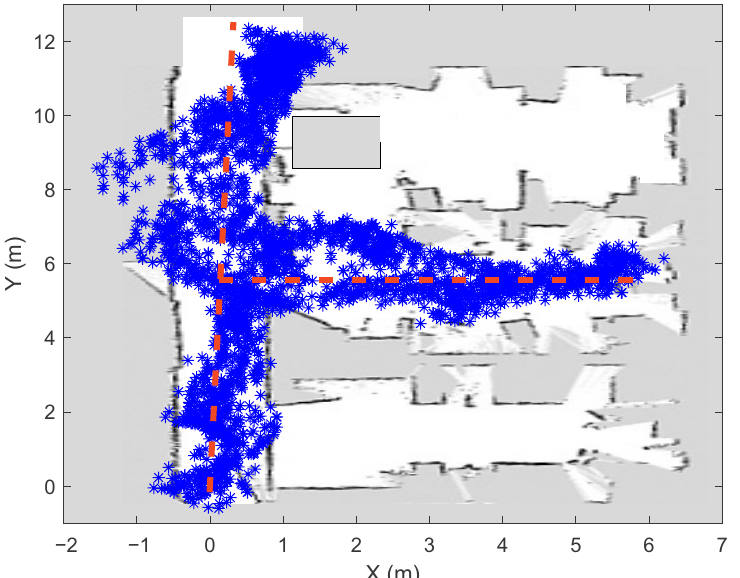
Figure 6. The indoor positioning results (after 5 min of walking) obtained using the online constructed path loss models and the PSO localization